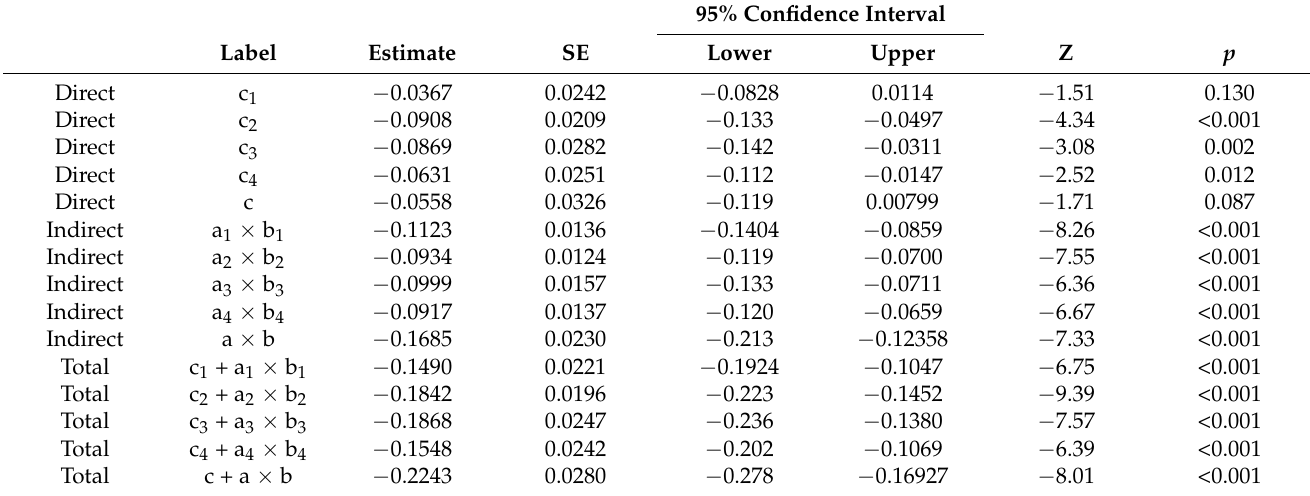
Table 3. Direct, indirect, and total